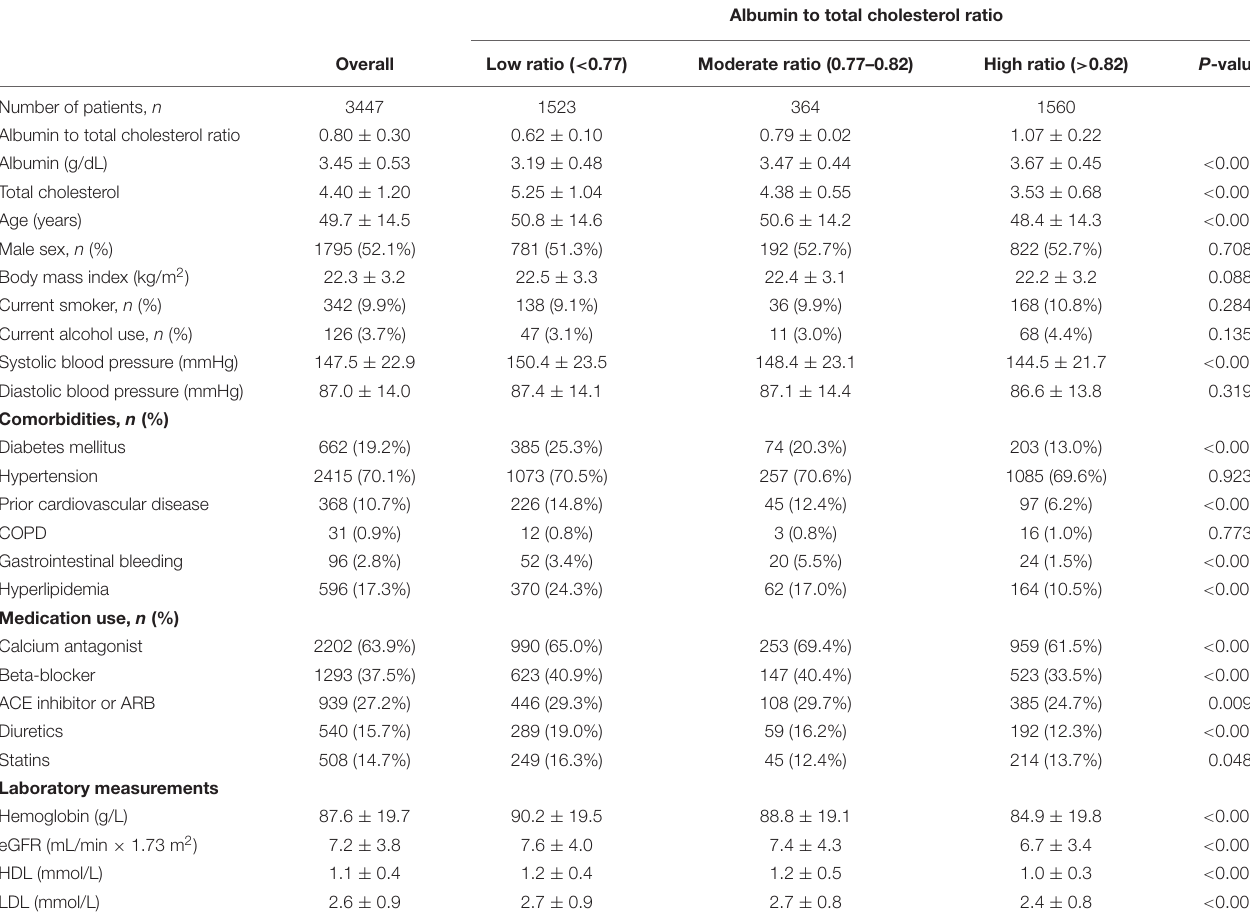
TABLE 1 | Baseline patient characteristics by categories of albumin to total cholesterol